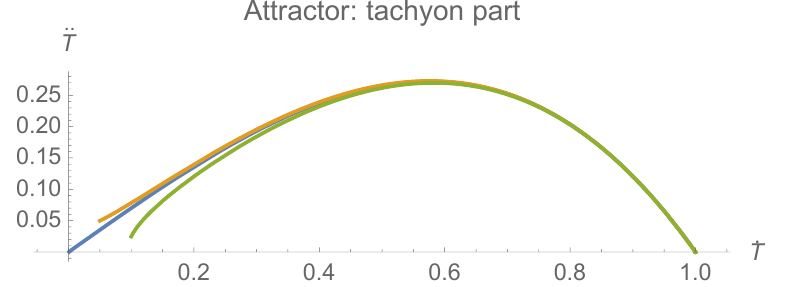
Figure 2 . The parametric plot of ˙ T and ¨ T obtained by numerically solving eq. (3.2) and eq. (3.3), which illustrates that ( ˙ T , ¨ T ) = (1 , 0) is a dynamic attractor for the coupled tachyon field. The longest curve is plotted with the initial condition ( T (0) , ˙ T (0) , ϕ (0) , ˙ ϕ (0)) = (0 . 001 , 0 . 001 , 10 − 8 , 0) and the other two curves are plotted with (0 . 1 , 0 . 05 , 3 × 10 − 8 , 0) and (0 . 05 , 0 . 1 , 2 × 10 − 8 , 0) respec- tively. In this numerical simulation, we have neglected the red-shifted term ( 3 H ) for the expanding phase and neglected the λϕ 4 term near ϕ ' 0 region for